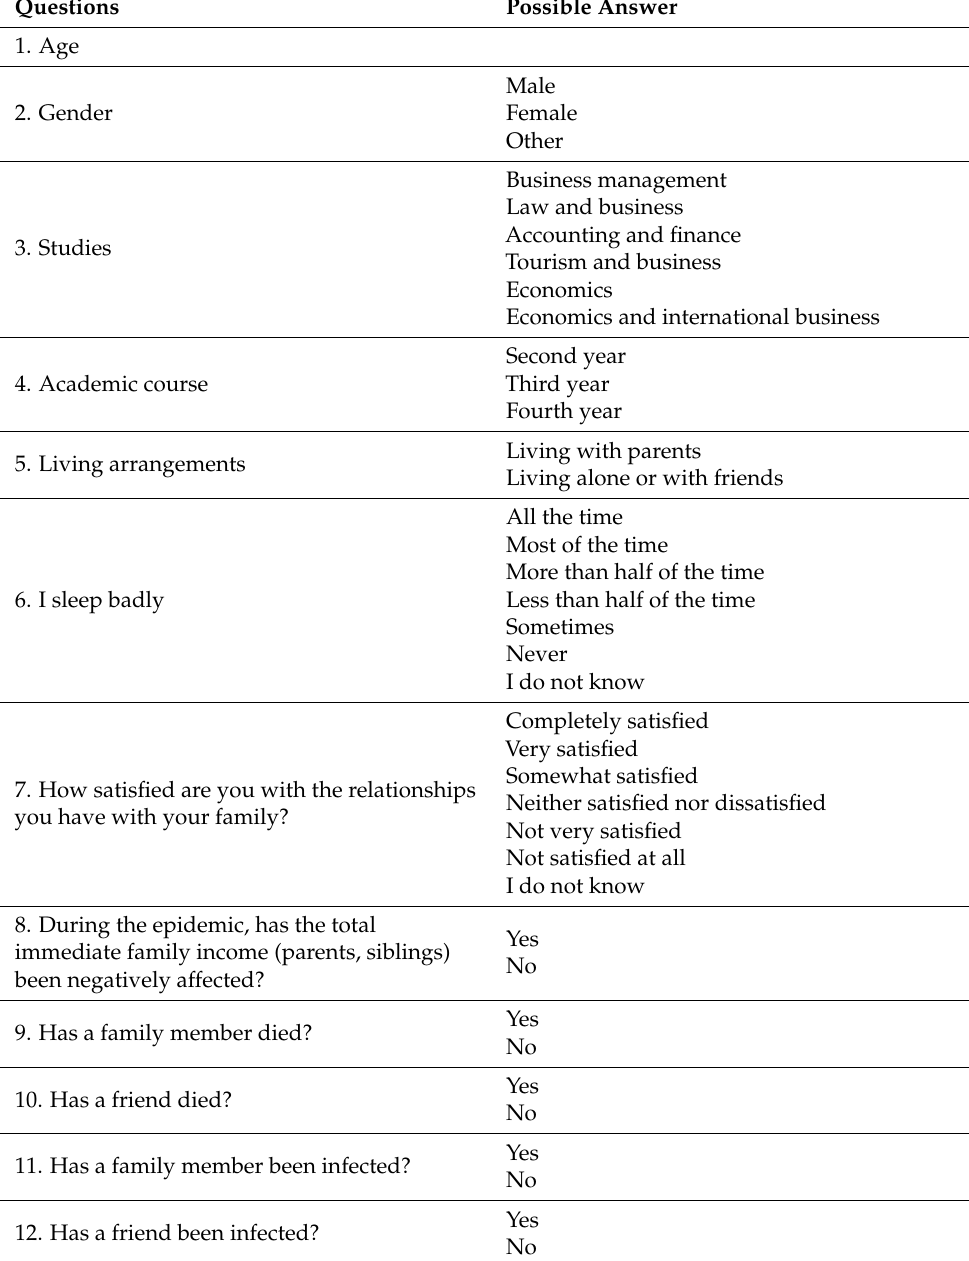
Table A1. SURVEY at Point 1 and Point